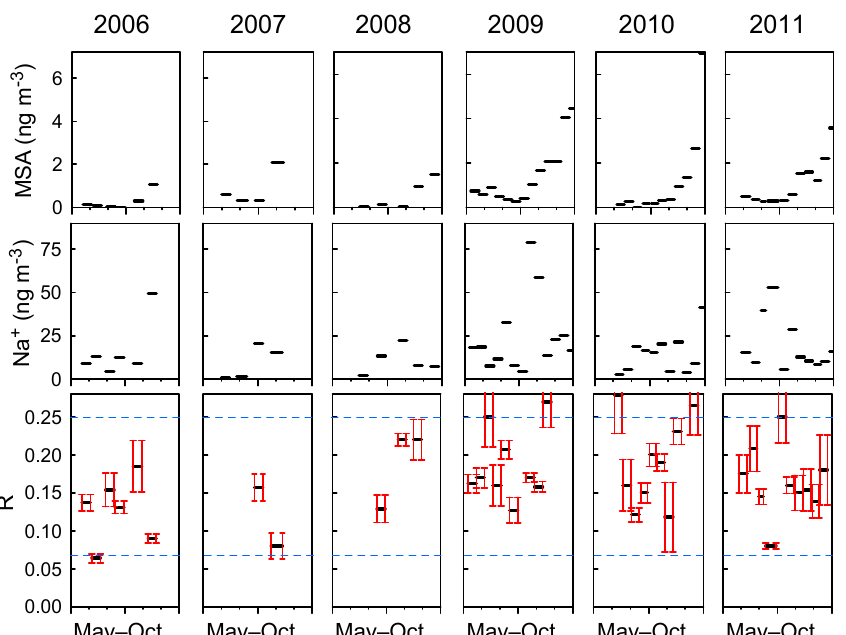
Figure 10. Year-round winter composition of aerosol collected on the 12-stage impactor sampler. MSA and sodium refer to the total concen- tration (i.e., the sum of concentrations observed on the 12 stages). R is the sulfate to sodium mass ratio of sea-salt aerosol. R values were derived from sulfate and sodium present on the impactor stages that collected most of sea salt (from 0.5 to 2µm diameter; see examples reported in Figs. 8 and 9) and for which sulfate concentrations have been corrected from its biogenic fraction (Eq. 5). Vertical bars refer to uncertainties related to the estimation of R (Eq. 7). The two horizontal dashed lines (in blue) refer to the R value in seawater (0.25, upper line) and in strongly fractionated sea-salt aerosol as observed in winter at the coast (0.07, lower